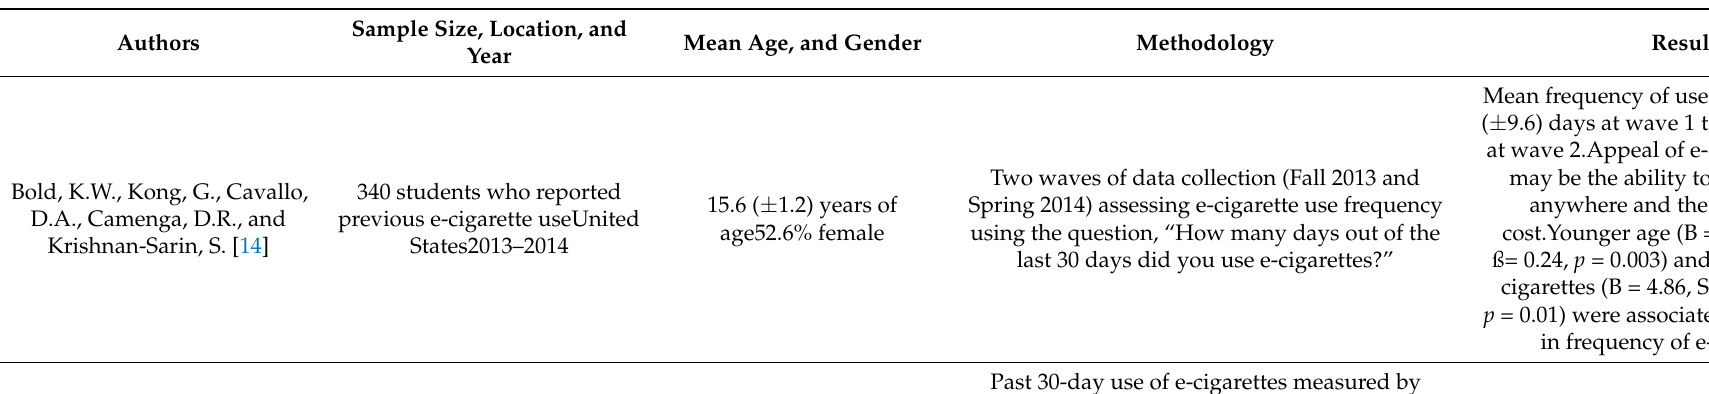
Table 1. Characteristics and results of included